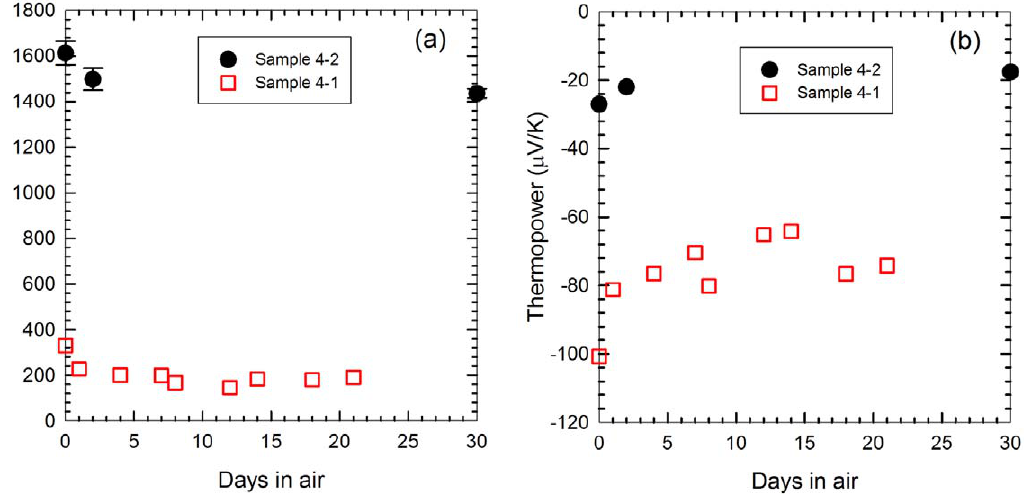
Figure 5. Change in electrical conductivity (a) and thermopower (b) as a function of time. The elapsed time was measured after the vacuum annealing (last process for fabricating samples) for Series 4 samples.